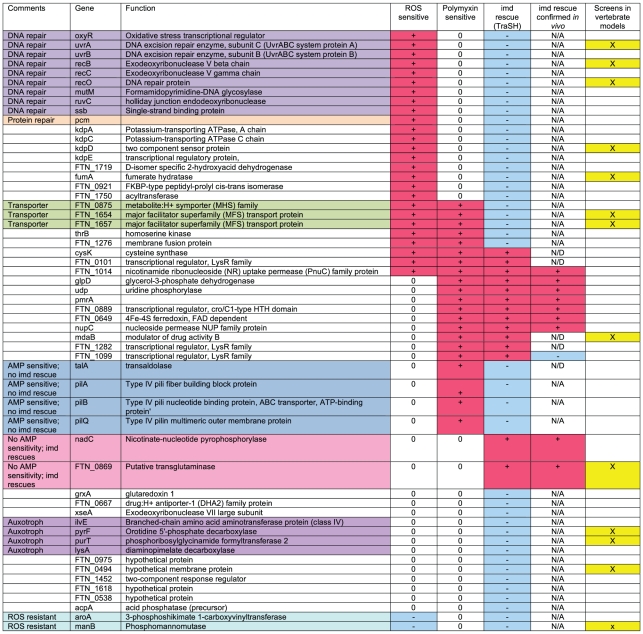
Summary of results of negatively selected mutant phenotypes.Mutants with confirmed attenuated phenotypes by competitive index are categorized by their sensitivity to oxidative stress and polymyxin and phenotype in imd mutant flies. To be considered attenuated, each mutant listed in this table was determined to have competitive indexes that were statistically significantly less than 1 by one sample t-tests with a maximum p value of <0.05. + indicates increased sensitivity, − indicates decreased sensitivity, and 0 indicates no change. N/A indicates that the assay was not applicable to that mutant, and N/D indicates test not done. In the “imd rescue” column, + indicated that the phenotype is rescued in imd mutants, − indicates no rescue. The “screens in vertebrate models” column indicates which mutants were identified in screens for F.novicida mutants previously.